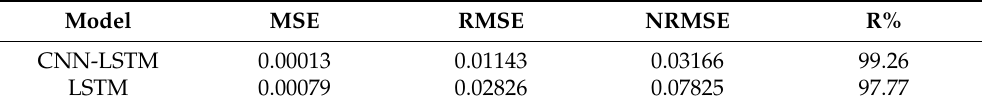
Table 3. Deep learning results for predicting the closing price of Tesla during the testing phase.